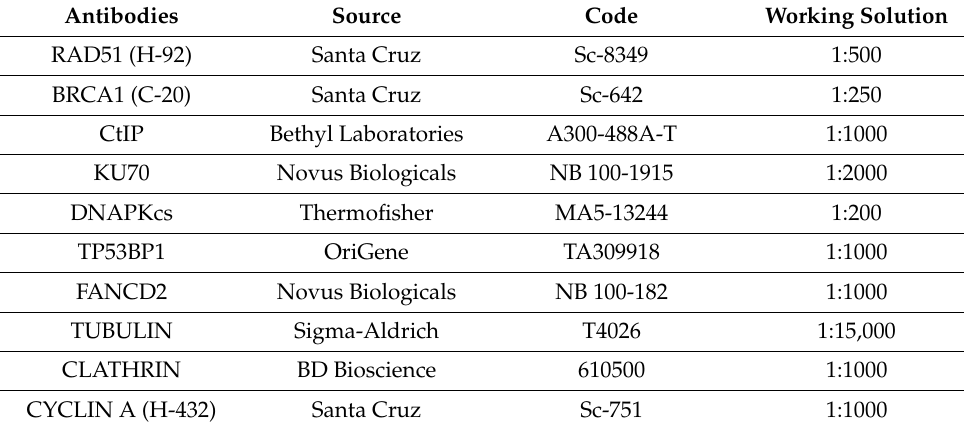
Table 1. List of the antibodies, commercial sources and dilutions used in this